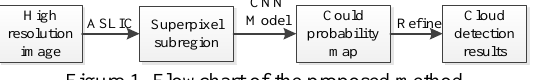
Figure 1. Flowchart of the proposed